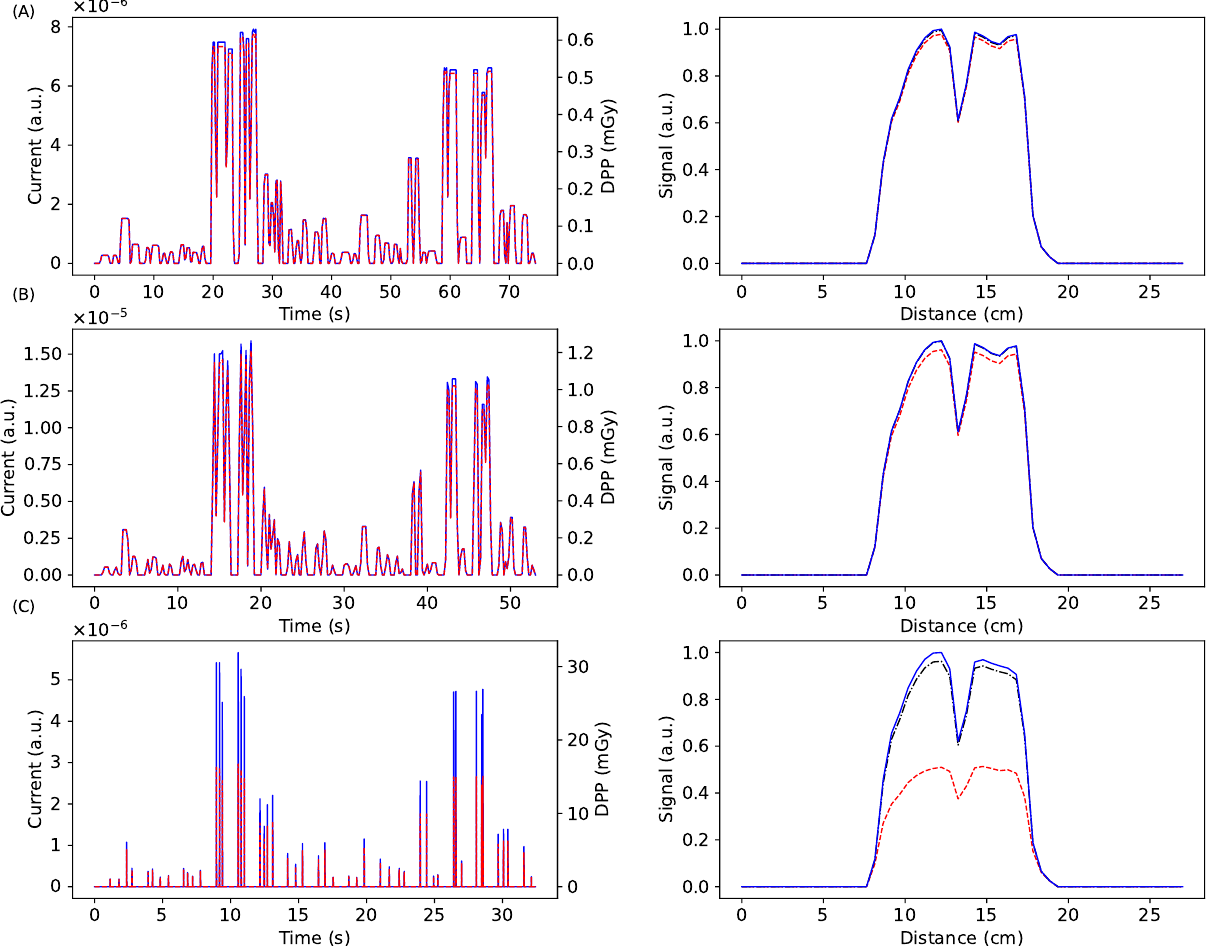
Figure 5. Effect of recombination and recombination correction in the verification of a dynamic radiotherapy clinical treatment with a PTW729-like air-chamber. The dynamic dose rate corresponds to that of a lymph node tumor treatment, but scaled up to deliver a maximum dose per pulse of 1 ( A ), 2 ( B ) and 50 mGy ( C ). In the left panels we show for a particular pixel the raw readout current (red lines) and corrected readout current (blue lines) versus time. Notice that the dose per pulse in this pixel does not reach the maximum dose per pulse of the delivery. In the right panels we show a profile of the radiation field (the one shown in Figure 2), including generated charge (solid line), raw collected charge (dashed line), and corrected charge (dash-dot